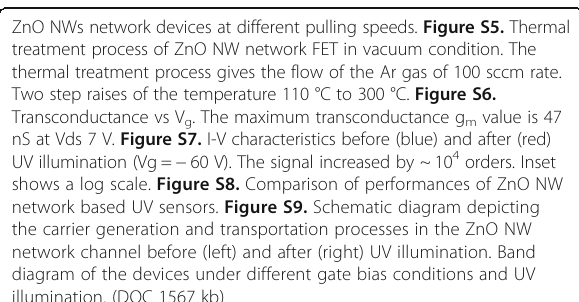
ZnO NWs network devices at different pulling speeds. Figure S5. Thermal treatment process of ZnO NW network FET in vacuum condition. The thermal treatment process gives the flow of the Ar gas of 100 sccm rate. Two step raises of the temperature 110 °C to 300 °C. Figure S6. Transconductance vs V g . The maximum transconductance g m value is 47 nS at Vds 7 V. Figure S7. I-V characteristics before (blue) and after (red) UV illumination (Vg= − 60 V). The signal increased by ~ 10 4 orders. Inset shows a log scale. Figure S8. Comparison of performances of ZnO NW network based UV sensors. Figure S9. Schematic diagram depicting the carrier generation and transportation processes in the ZnO NW network channel before (left) and after (right) UV illumination. Band diagram of the devices under different gate bias conditions and UV illumination. (DOC 1567